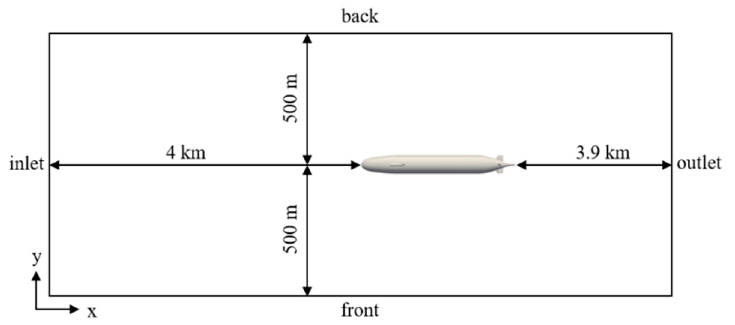
Figure 9. Top view of the computational domain.